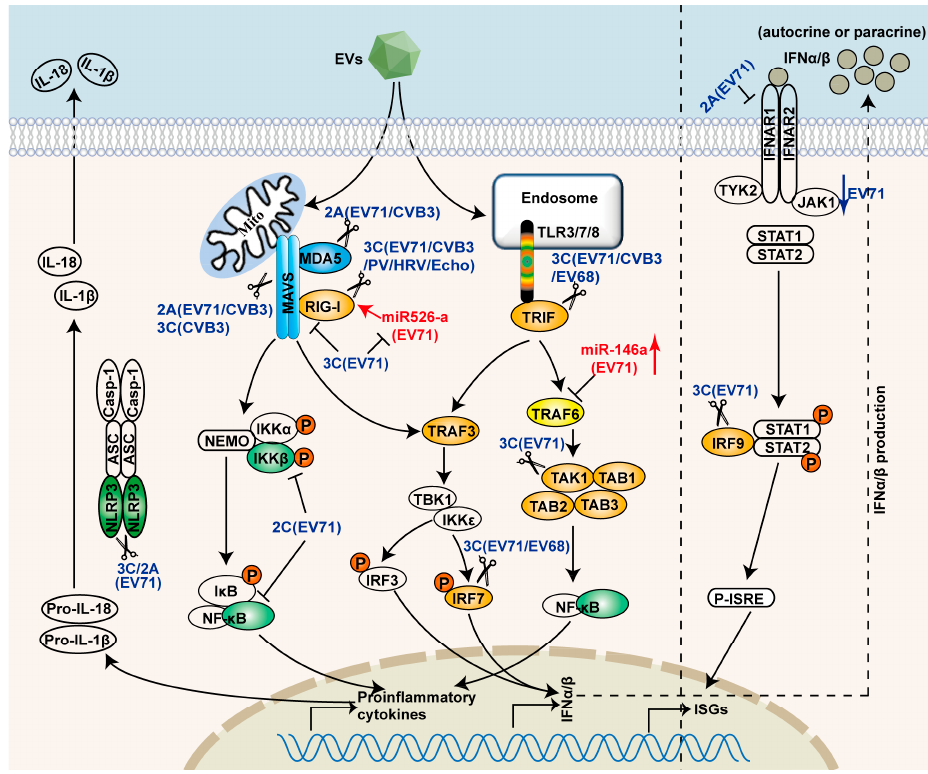
Figure 1. Evasion of PRRs-mediated signaling pathways by EVs. EVs target PRRs signaling pathways by non-structural proteins, 2A, 2C, and 3C. 2A cleaves MAVS and MDA5, and degrades IFNAR1. 2C inhibits NF- κ B activation. 3C disrupts the RIG-I and MAVS complex, and cleaves TRIF, IRF9, IRF7, TAK1, and TAB1/2/3. The scissors represent cleavage. 3C also inhibits miR-526a-mediated RIG-I activation. EV71 can also evade innate immunity by inducing the expression of miR-146a.